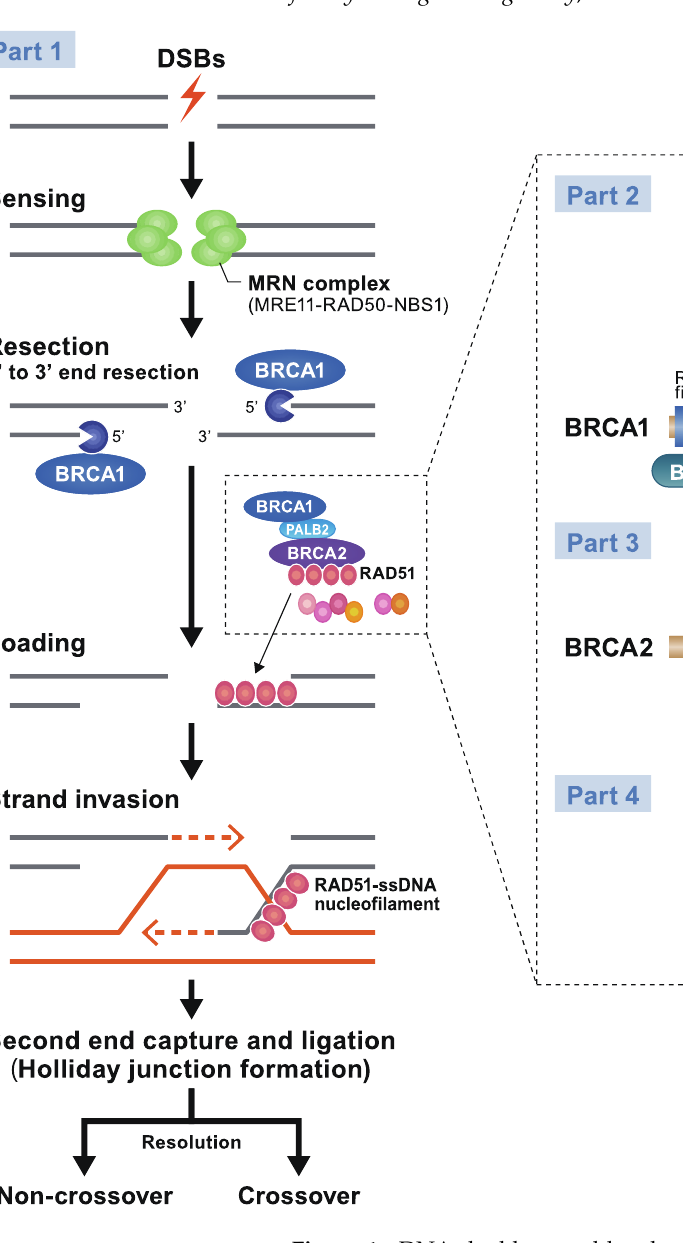
Figure 1. DNA double-strand breaks (DSBs) repair by homologous recombination (HR) and key molecules (MRN complex, ATM, CHK2, BRCA1, PALB2, BARD1, BRIP1, BRCA2, RAD51, RAD51C, and RAD51D). Part 1 (overall HR pathway against DSBs). In response to DSBs or stalled replication fork (not shown), the initial step for HR is the sensing of damaged sites by the MRN complex, which is comprised of MRE11, RAD50, and Nijmegen breakage syndrome protein 1 (NBS1 or, alternatively, NBN), followed by the resection procedure. Either side of DNA is lysed from 5 ′ to 3′ by MRE11 (shown like “PAC - MAN” in this figure) with its exonuclease and endonuclease activities and BRCA1 enzymatic activities, forming an overhanging 3′ single-stranded DNA (ssDNA) end which can invade homologous template. RAD51 is recruited by the BRCA1 – PALB2 – BRCA2 effector complex and is loaded on ssDNA to form RAD51 – ssDNA nucleofilament. Recombinase RAD51 synthesizes DNA using sister chromatids as a template, extending to the second DNA end, which is terminated by D-loop capture (not shown), and forms a double Holliday junction (not shown), resulting in non-crossover or crossover outcomes via resolution. Parts 2 – 4 (magnified view of BRCA1 – PALB2 – BRCA2 complex and molecular associates). In response to DSBs, a serine/threonine kinase ATM, another sensor molecule of DSBs, is recruited with checkpoint activation and phos- phorylation of checkpoint kinase 2 (CHK2) to recruit the BRCA complex (Part 2). BRCA1 (1863 amino acids (a.a.)) is phosphorylated by ATM or ATR (ATR works when stalled replication fork